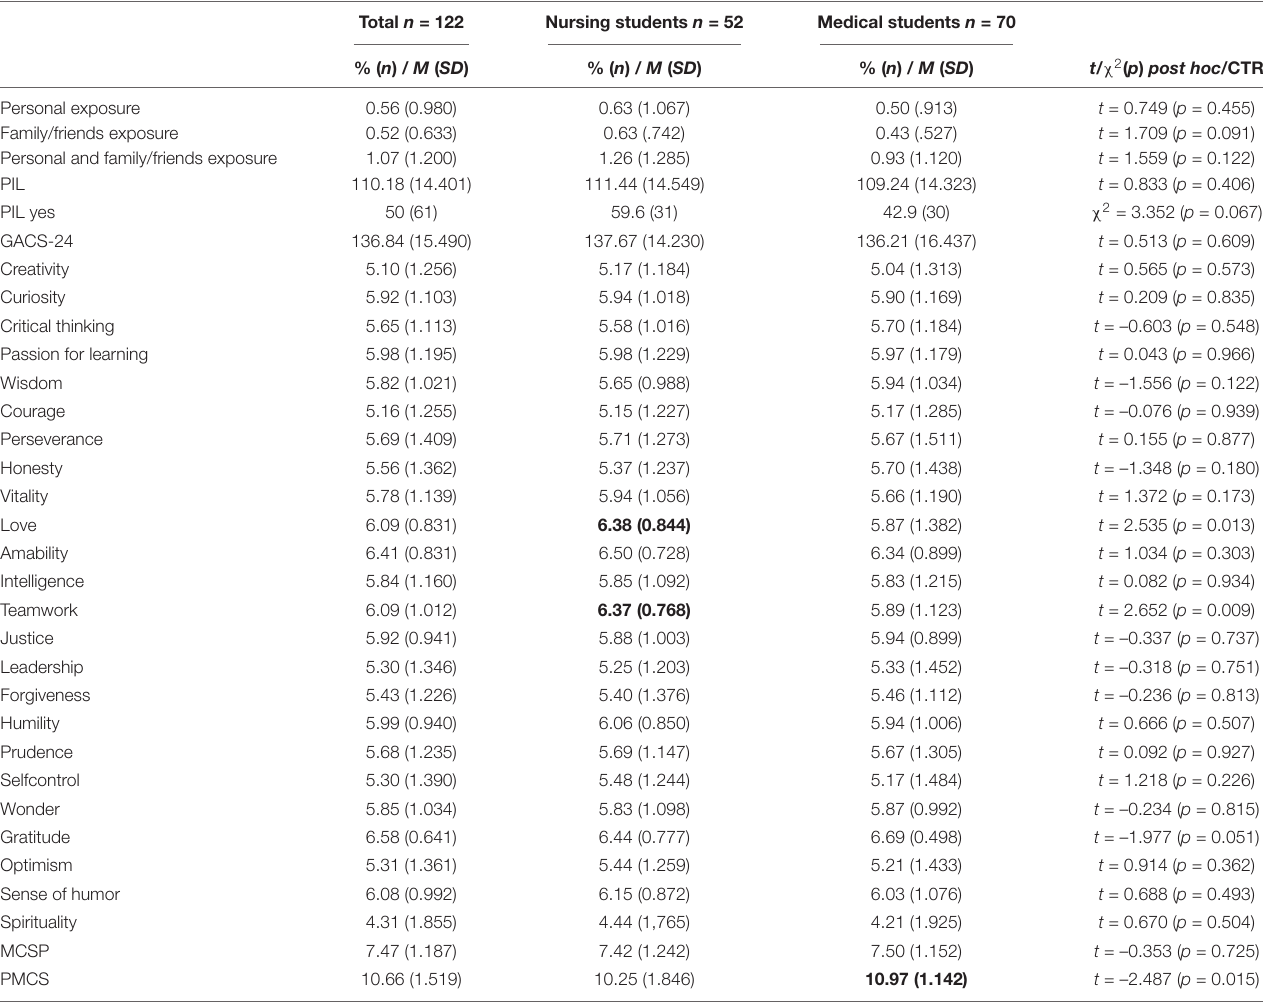
TABLE 2 | Exposure to SARS-CoV-2 and moderating